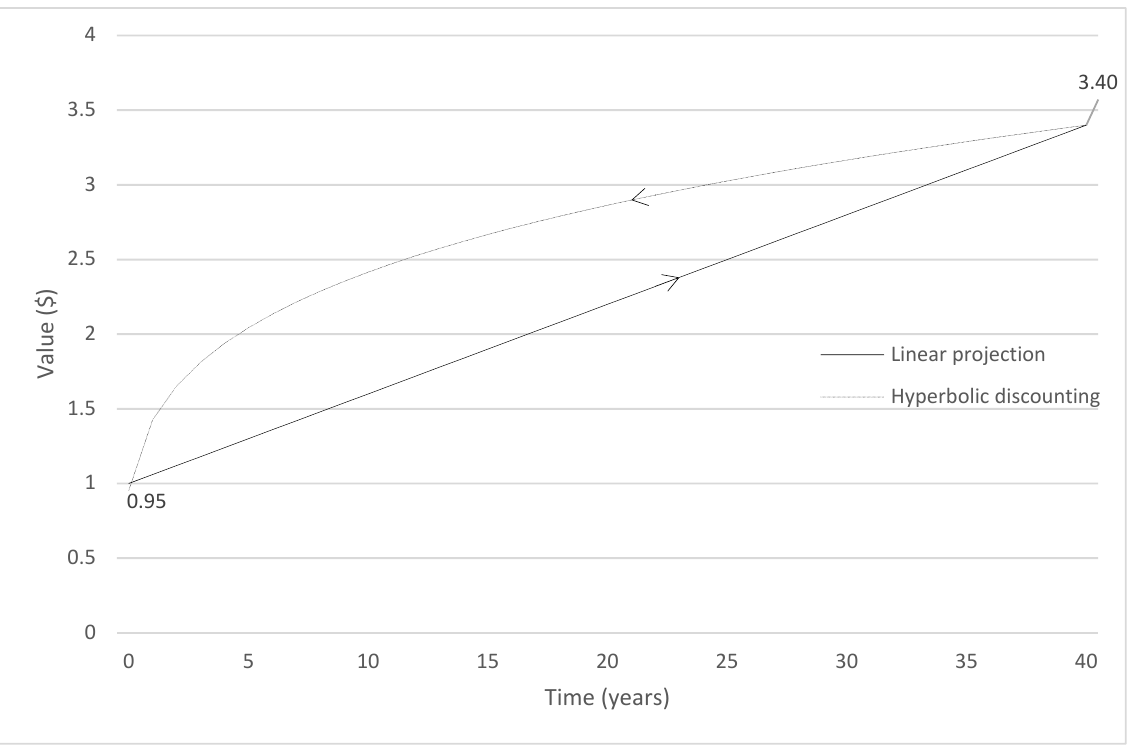
Figure 3. Linear projection with hyperbolic discounting.